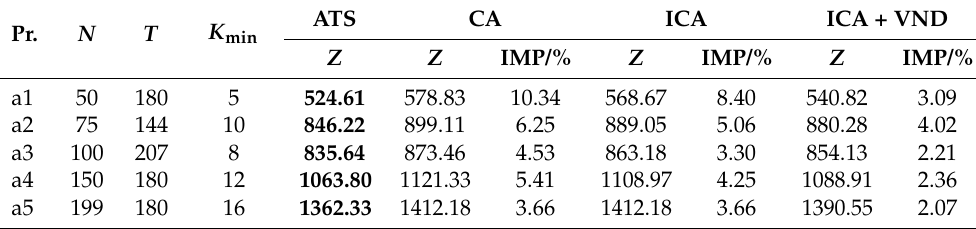
Table 4. Comparison results of the adaptive tabu search (ATS) with others in the literature.